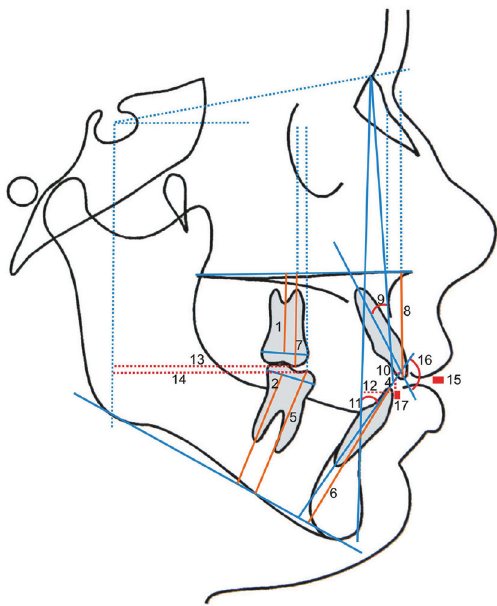
Figure 5- Angular and linear dentoalveolar